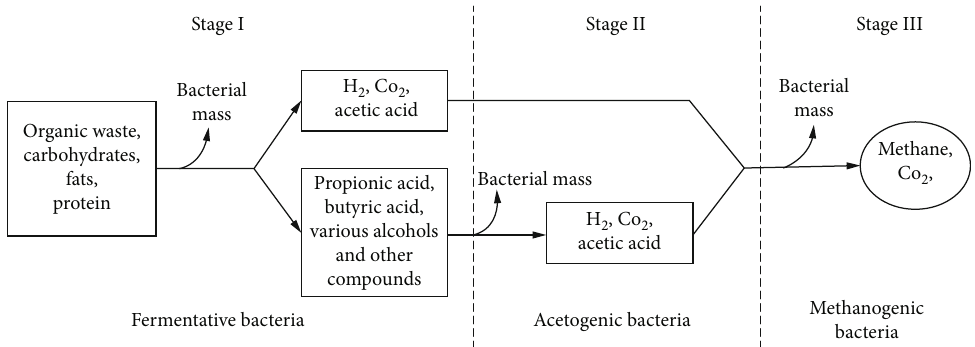
Figure 5: Summary of the biogas formation process